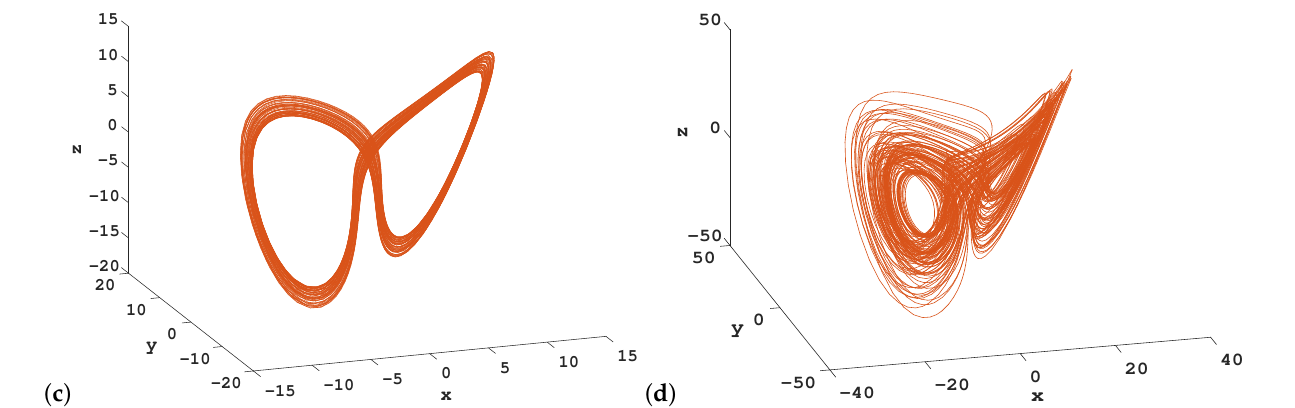
Figure 6. Some representative dynamical behaviors of system (2) with parameters ( a , c , k , m ) = ( 10,2.7, − 0.2,1 ) and different values of b : ( a ) b = 10; ( b ) b = 20; ( c ) b = 42; ( d ) b = 120.